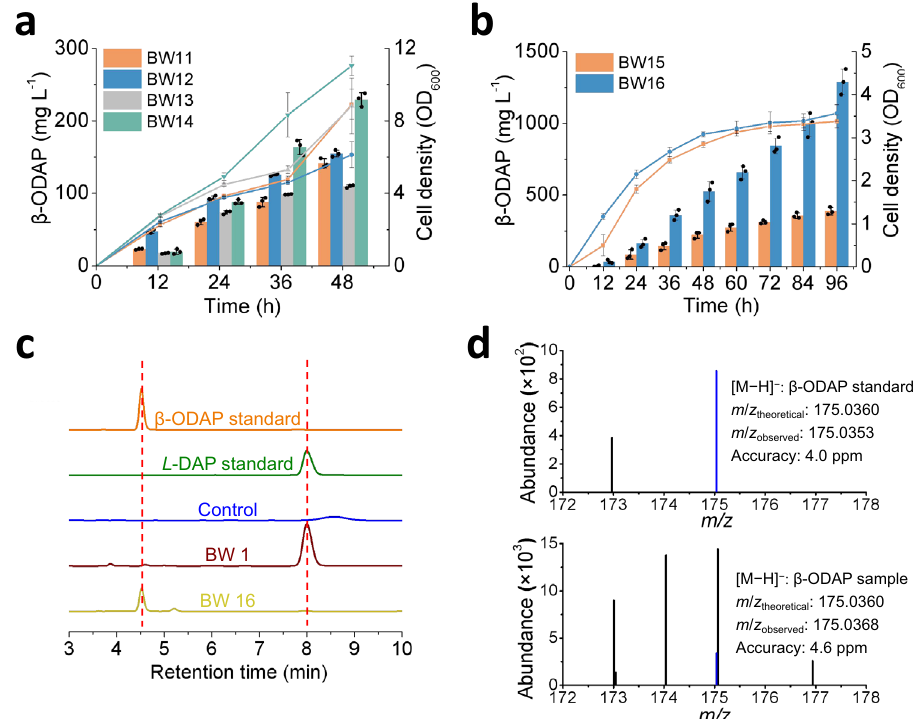
Fig. 4 | Denovo biosynthesis of β -ODAP.a Comparison of β -ODAP production by three arti fi cial pathways and synergy pathway. b Effectof knocking out of serB and overexpressing of aceA on β -ODAP production. The bars indicate the titer of β - ODAP and the lines indicate biomass at OD 600 . c High-performance liquid chro- matography (HPLC)analysisof the β -ODAPstandard, L -DAP standard,thenegative control strain (BW harboring empty vectors pZE12-luc and pCS27), the fermented